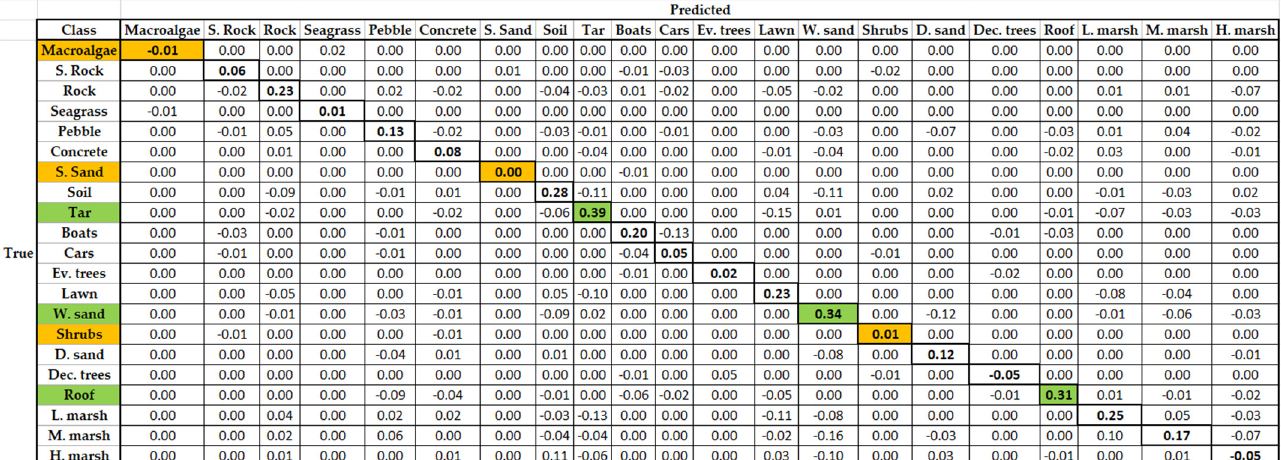
Figure A4. Confusion matrix obtained by the random forest classification of the green waveforms’ features. The three highest and three lowest class accuracy values are highlighted in green and orange, respectively. S. = submerged, Ev. = evergreen, Dec. = deciduous.